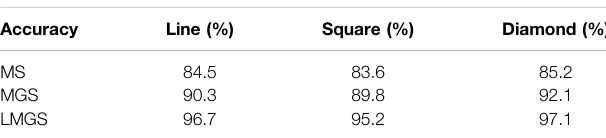
TABLE 1 | Classi fi cation